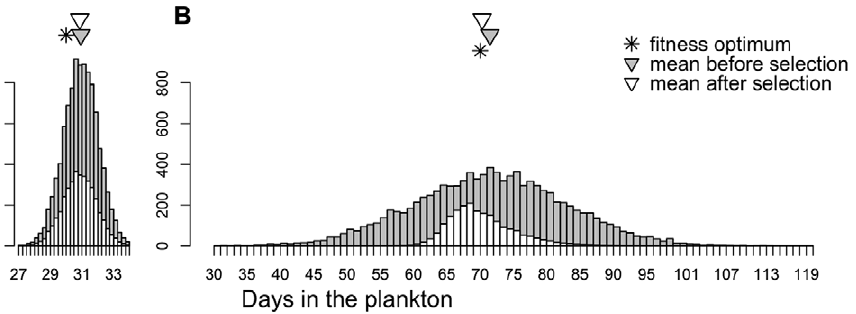
Figure 2. Phenotypic variation in planktonic duration at high CO 2 before and after simulated selection for (A) M.trossulus and (B) S.franciscanus . Variation in planktonic duration was approximated from variation in size-at-day for either species under high CO 2 . Frequency of phenotypes before selection (dark bars) and after selection (light bars) are shown.